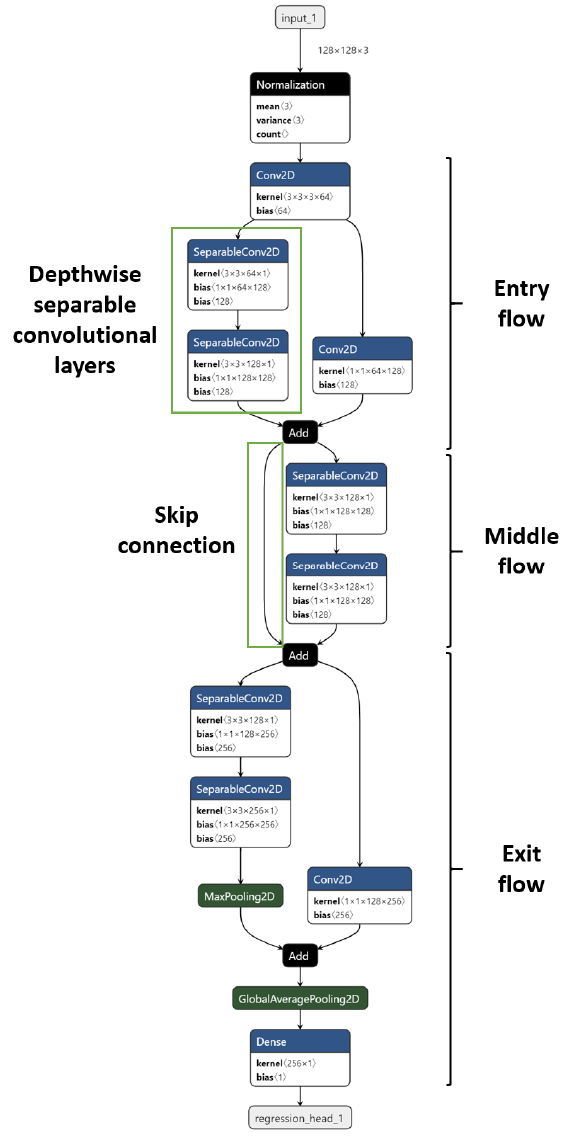
Figure 8. An eight-layer mini Xception model with 207,560 parameters was the best architecture discovered in 50 and 100 trials. Three main parts (entry, middle, and exit flows) and two key features (indicated by green boxes), namely the depthwise separable convolutional layers and skip connections from the original Xception network [48] can be discerned. The best performance was provided by the model from 100 trials.